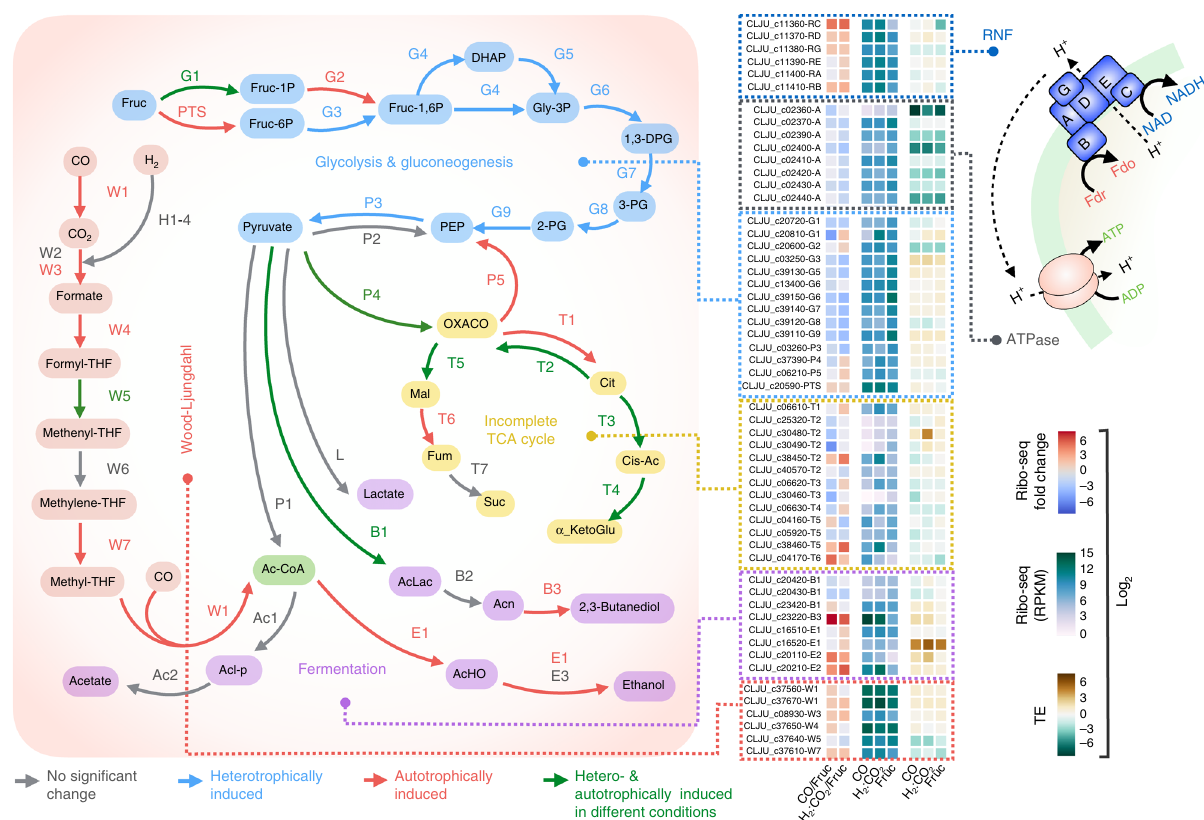
Fig. 3 Metabolic map of major carbon and energy pathways exhibiting differential translation and differential TE. Differential fold change is calculated as the log 2 CO/fructose or H 2 :CO 2 /fructose translation ratios. Heterotrophically induced (red arrows), autotrophically induced (blue arrows), insigni fi cant (gray arrows) and condition-speci fi c (green arrows) translation is depicted in all pathways. Glycolysis and Gluconeogenesis: fructose phosphotransferase system (PTS); fructokinase/fructose-6-phosphate isomerase (G1); 1-phosphofructokinase (G2); 6-phosphofructokinase (G3); ketose-bisphosphate aldolase (G4); triose-phosphate isomerase (G5); glyceraldehyde-3-phosphate dehydrogenase (G6); phosphoglycerate kinase (G7); phosphoglycerate mutase (G8); enolase phosphopyruvate hydratase (G9); pyruvate:ferredoxin oxidoreductase (P1); pyruvate, phosphate dikinase (P2); pyruvate kinase (P3); pyruvate carboxylase (P4); PEP carboxykinase (P5). Fermentation : phosphotransacetylase (Ac1), acetate kinase (Ac2), bifunctional aldehyde/alcohol dehydrogenase (E1), aldehyde:ferredoxin oxidoreductase (E2), additional alcohol dehydrogenases (E3), acetolactate synthase (B1), acetolactate decarboxylase (B2), 2,3-butanediol dehydrogenase (B3); lactate dehydrogenase (L). Incomplete TCA cycle: citrate synthase (T1); citrate lyase (T2); aconitase (T3); isocitrate dehydrogenase (T4); malate dehydrogenase (T5); fumarase (T6); fumarate reductase (T7). Wood − Ljungdahl pathway :